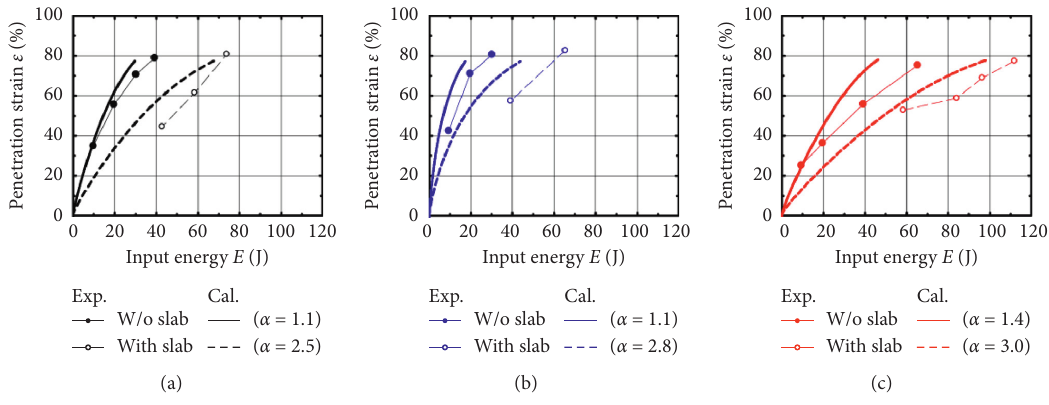
Figure 17: Weight penetration-input energy relationship. (a) ST. (b) PP. (c)